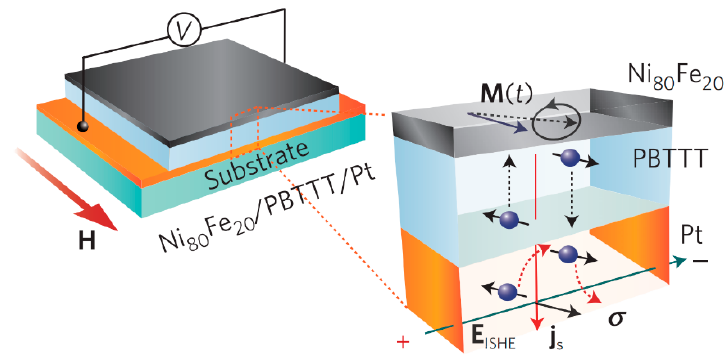
Figure 25. Schematic diagram of an organic pure spin current device by Watanabe et al. [18] with the permission of Nature Physics. The middle layer is an organic polymer film.